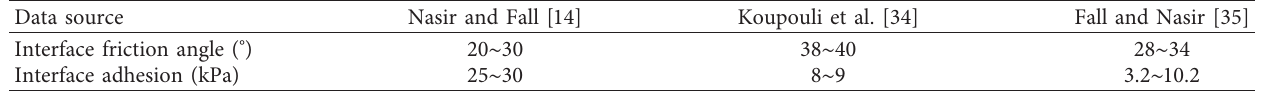
Table 1: Measured data of interface friction angle and adhesion.